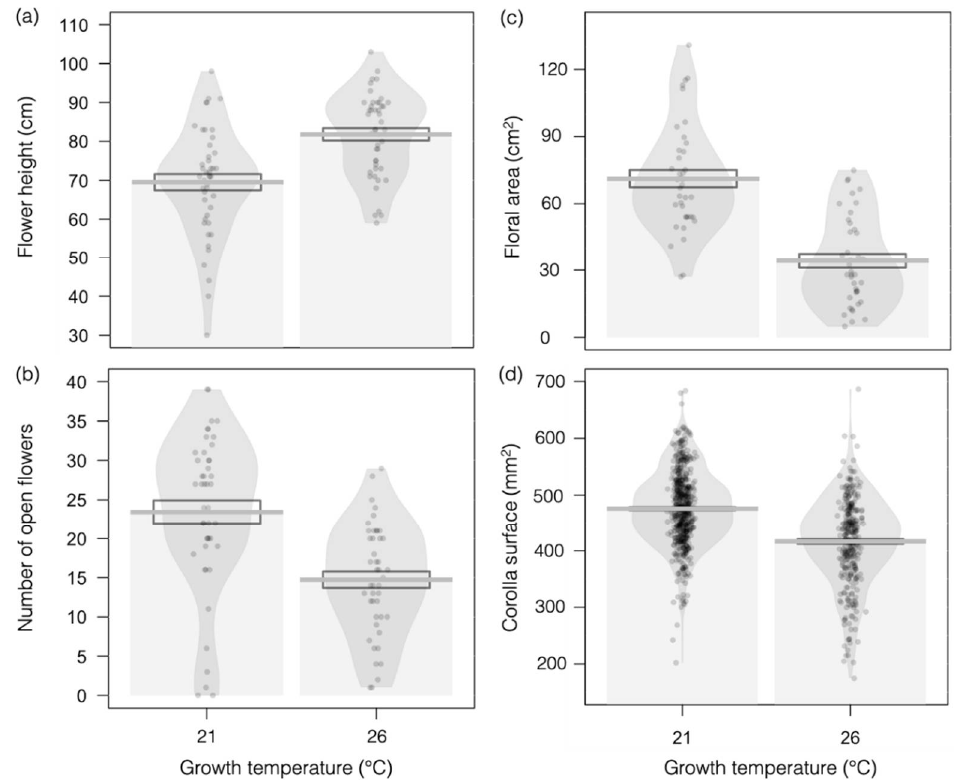
Figure 2. Effects of higher temperature on the visual floral traits of Borago officinalis. ( a ) Flower height (N = 88); ( b ) number of open flowers (N = 88); ( c ) floral area, as defined by the sum of all corolla surfaces per plant (N = 77); and ( d ) corolla surface (N = 909) in plants grown at 21 °C (left- side plots) or 26 °C (right-side plots). Data are presented as means ± standard errors (SEs) as box- plots and with raw data points included in light